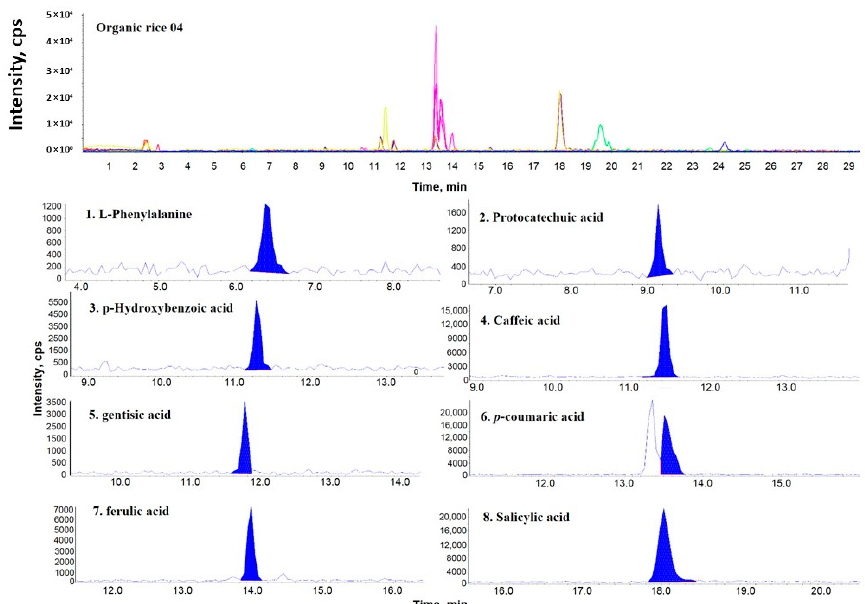
Figure 1. Representative multiple reaction monitoring (MRM) ion chromatogram of organic rice (OR)-04 and the corresponding extracted ion chromatograms of the detected phenolic compounds.